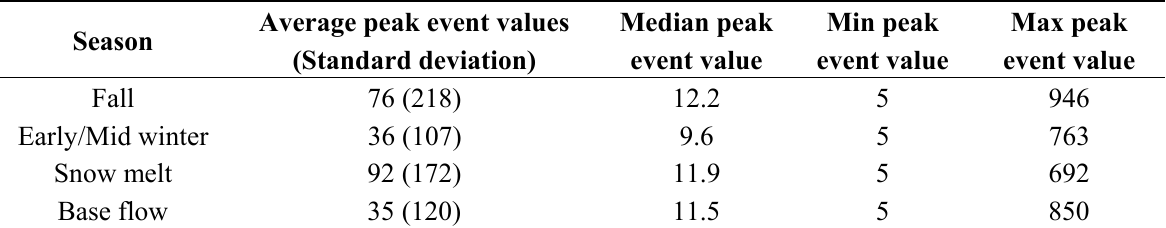
Table 5. Peak event turbidity values (NTU) by